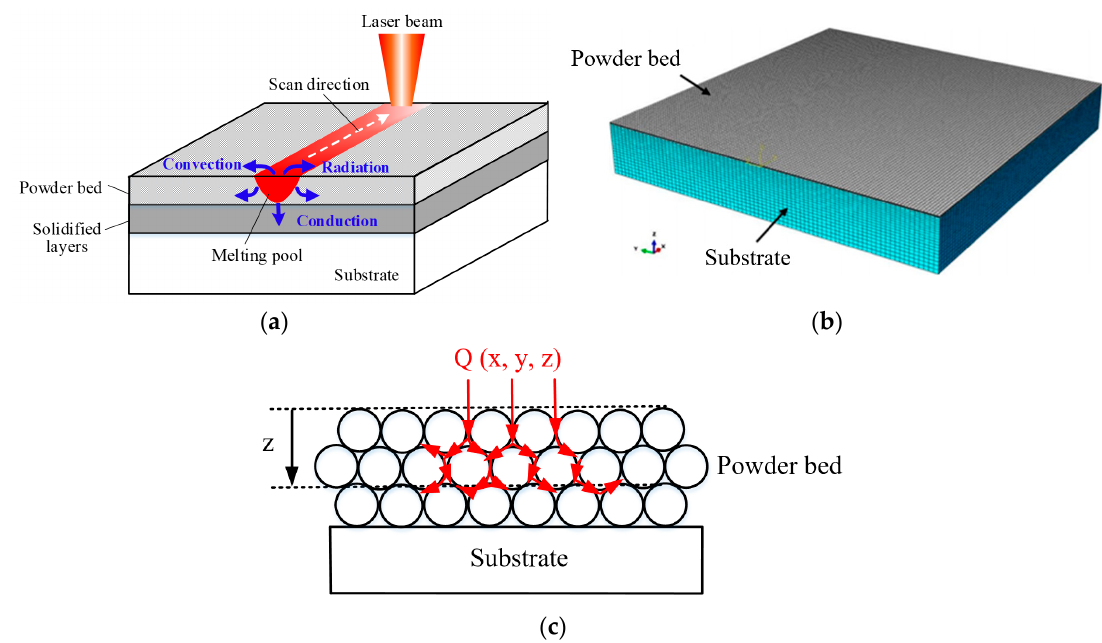
Figure 2. ( a ) Schematic showing the thermal behavior of the powder bed under laser irradiation. ( b ) 3D finite-element (FE) model. ( c ) Schematic showing the transfer of laser radiation into the powder bed.